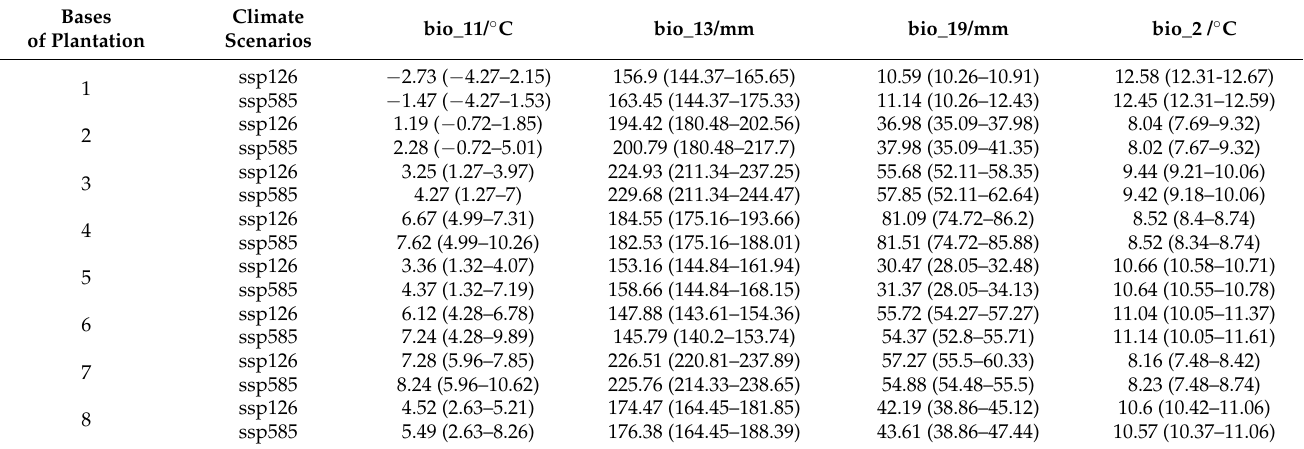
Table 9. The growth subregions of the main bases for C. bungei plantation. For the order of bases of plantation, see Table